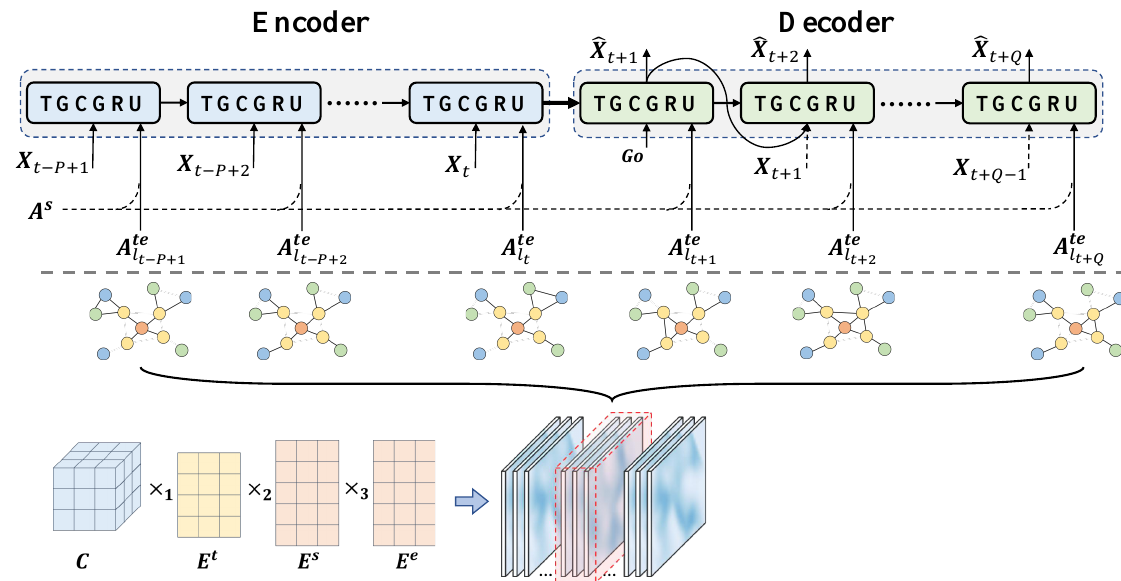
Figure 3. Overview of the proposed model